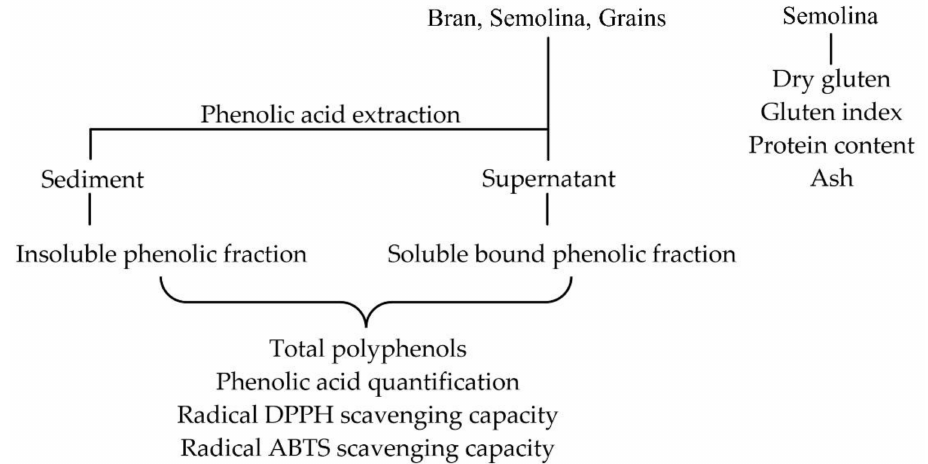
Figure 1. Flowchart of the process used for the extraction and analysis of the wheat